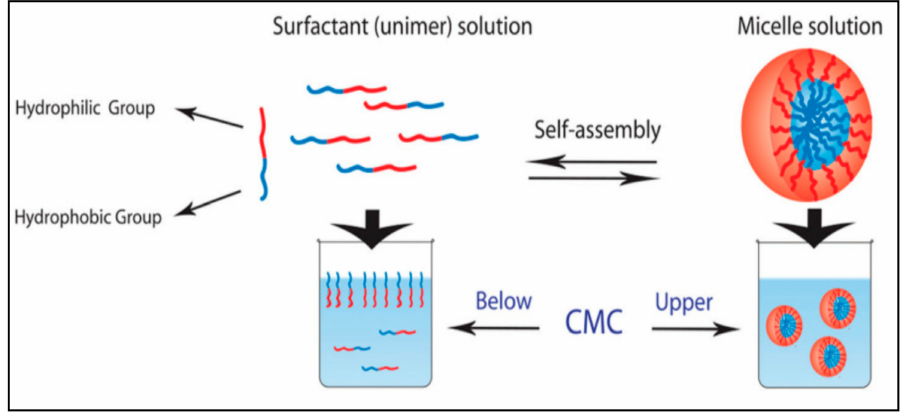
Figure 1. Schematic representation of unimer–micelle equilibrium in water. Reprinted with permis- sion from [33]. Copyright © 2017, The Royal Society of